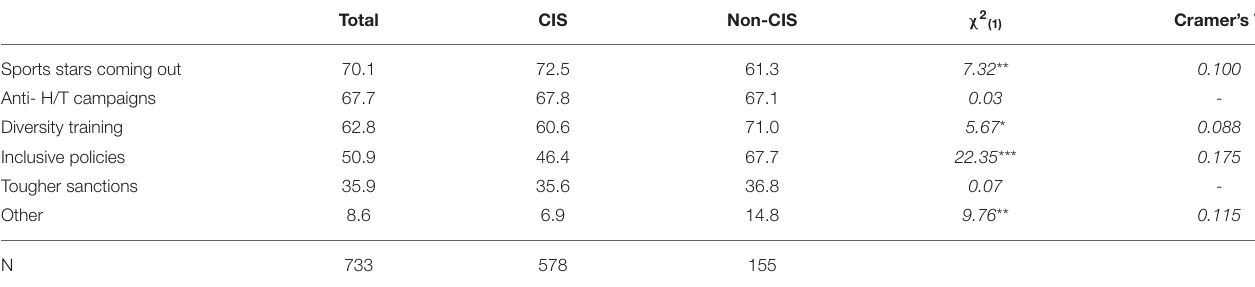
TABLE 5 | Helpful to tackle discrimination in sport by gender identity.